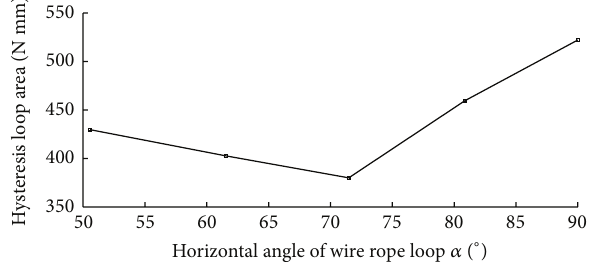
Figure 13: Hysteresis loop area versus the horizontal angle of the wire rope